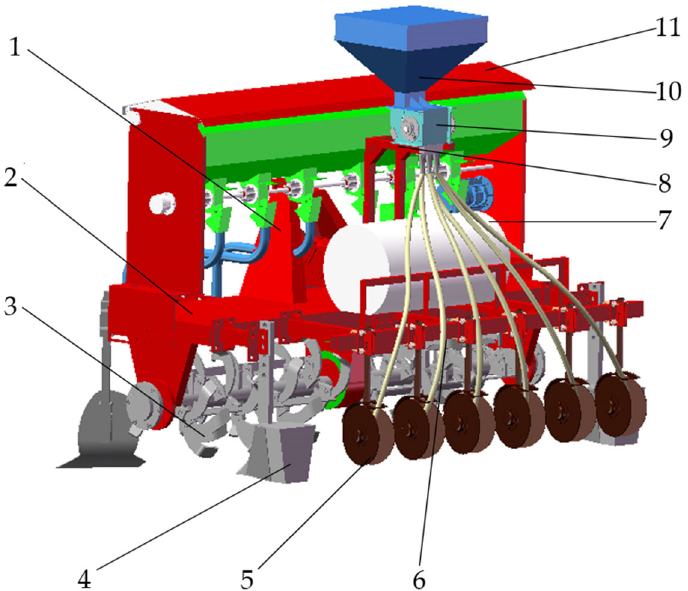
Figure 1. Structure of rapeseed seeder: (1) three ‐ point hitch, (2) main frame, (3) rotary tillage device, (4) ditching opening device, (5) double disc opener, (6) seed tube, (7) pesticide tank, (8) installation position of accelerometer, (9) centralized seed ‐ metering device, (10) seed box, and (11) fertilizer discharging device.